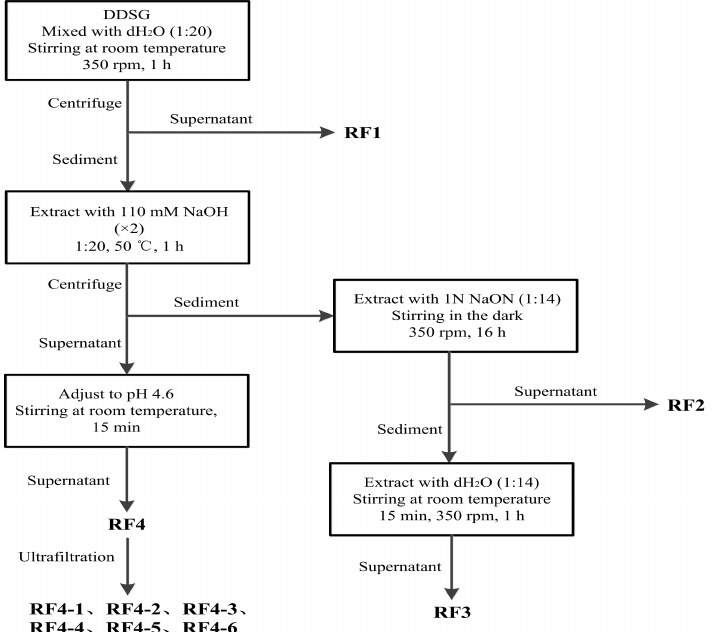
Figure 3. Flowchart for extraction melanoidins from dried distilled spent grain (DDSG). Four supernatants (RF1–RF4) containing melanoidins were obtained, and six different molecular weight (MW) fractions named RF4-1 (<3 kDa), RF4-2 (3 ‒ 10 kDa), RF4-3 (10 ‒ 30 kDa), RF4-4 (30 ‒ 50 kDa), RF4-5 (50 ‒ 100 kDa), and RF4-6 (>100 kDa) were obtained by ultrafiltration.